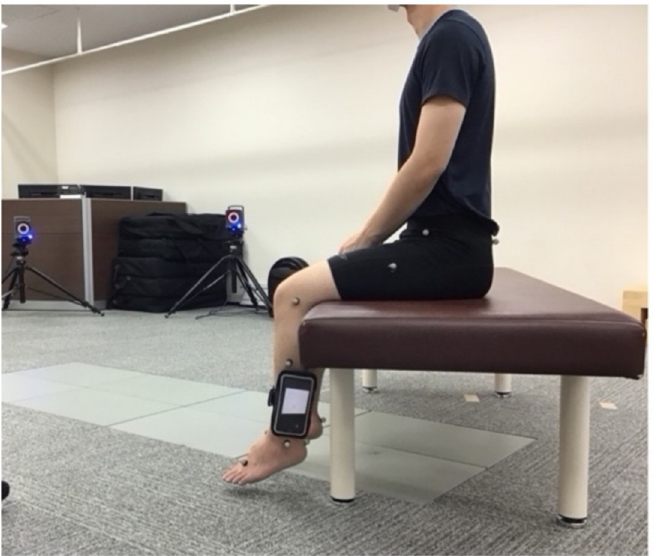
Fig 1. The knee JPS was measured on the non-dominant leg using VICON and an iPhone attached to the leg with a Velcro band. JPS: joint position sense.